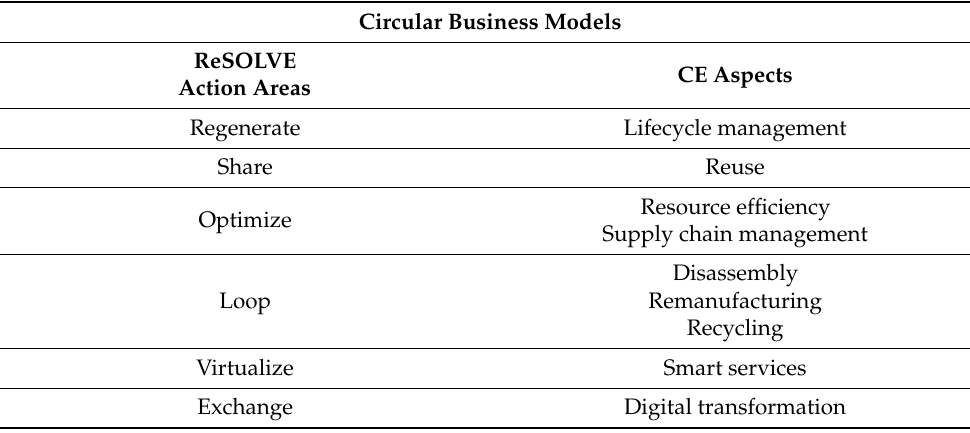
Table 1. Linkage of CE aspects with ReSOLVE’s